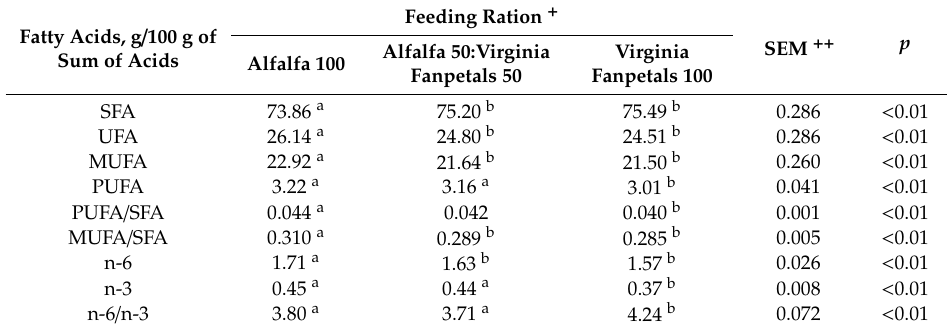
Table 7. Saturated, unsaturated and other groups of fatty acids in milk from lactating dairy cows fed di ff erent